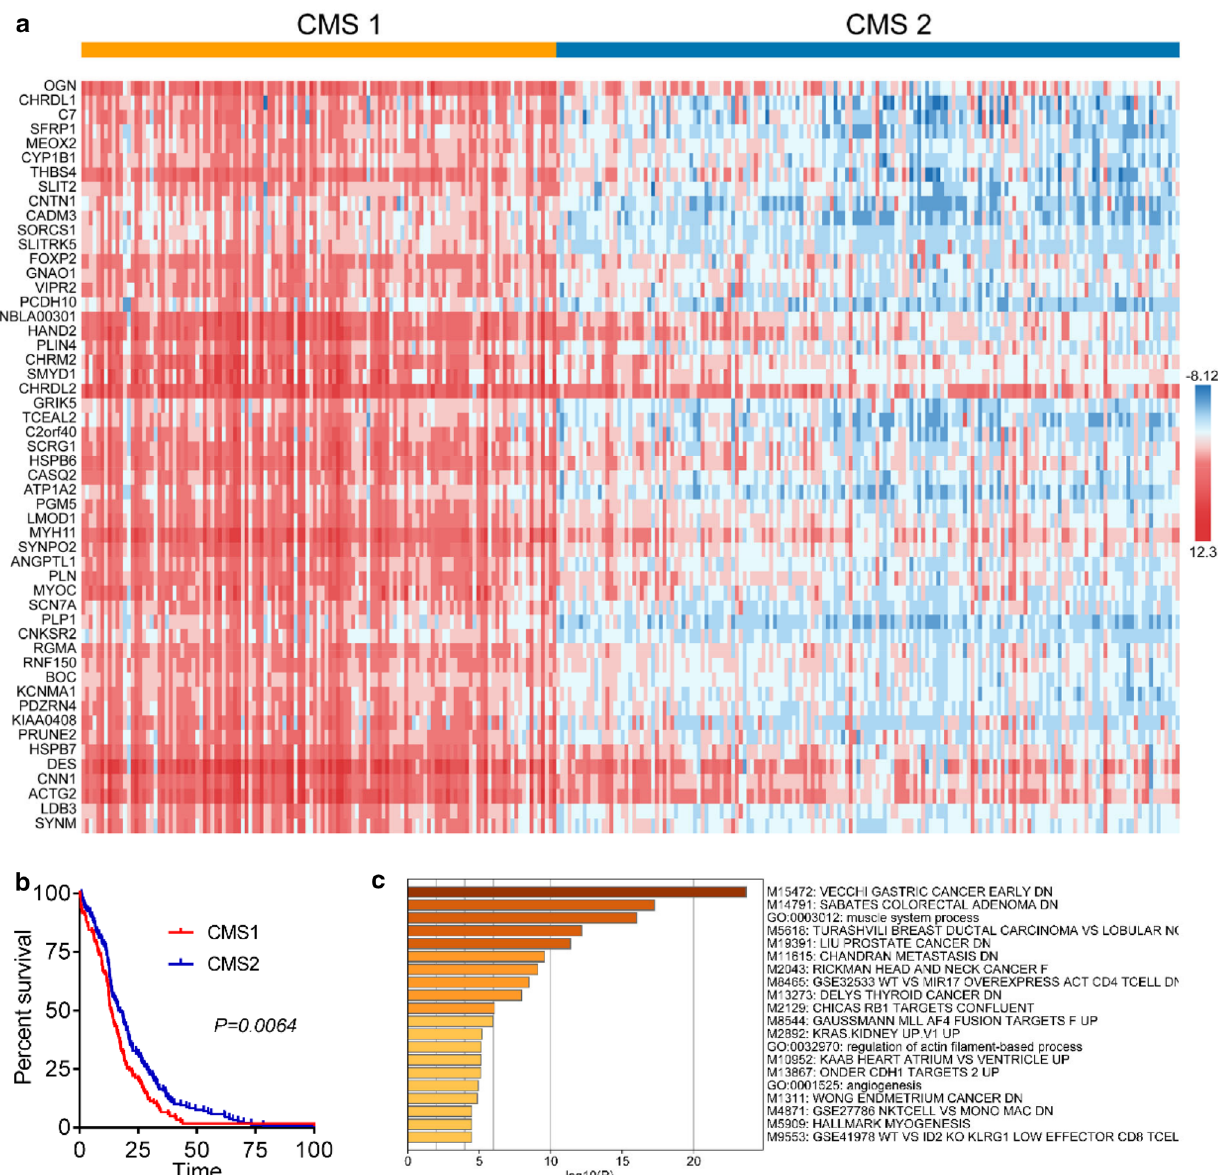
Fig. 1 Identification of robust genes associated with GC survival and their functional enrichment analysis. a Identification of key modules that prominent change in CMS1 vs. CMS2. b Kaplan–Meier survival analysis showed CMS1 had poor survival. c Gene ontology (GO) enrich- ment analysis of CMS selected genes in